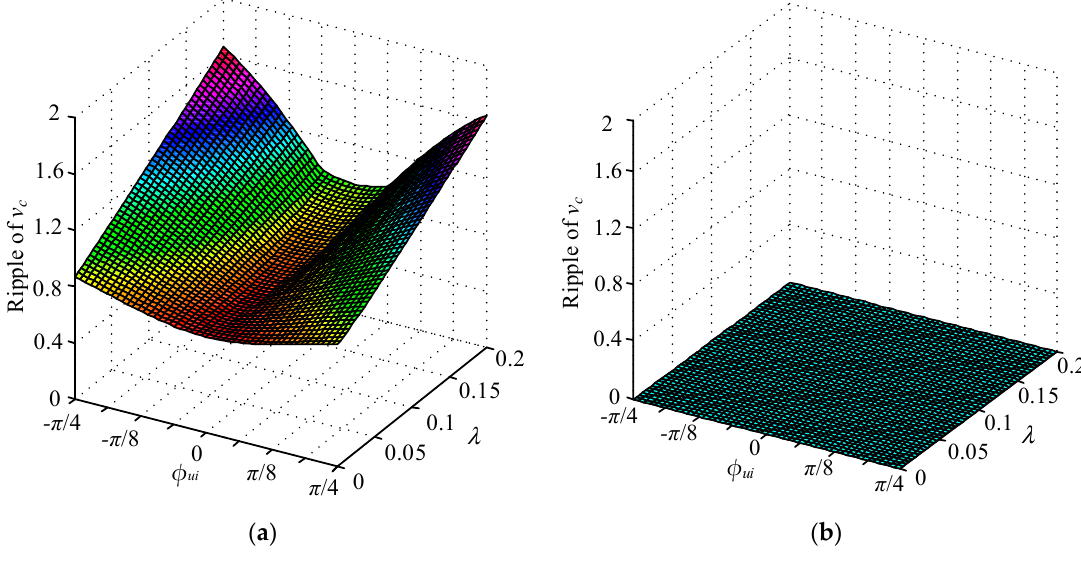
Figure 7. Surfaces of the ripple of v c as the function with φ ui and λ : ( a ) Traditional SPWM; ( b ) DCR-SPWM.